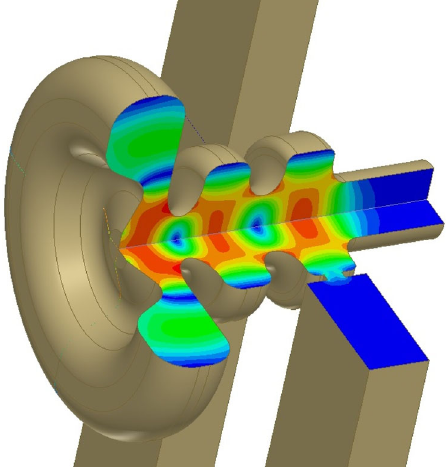
FIG. 2. Geometry of the CTF2 gun and amplitude of the electric field in the horizontal and vertical section.